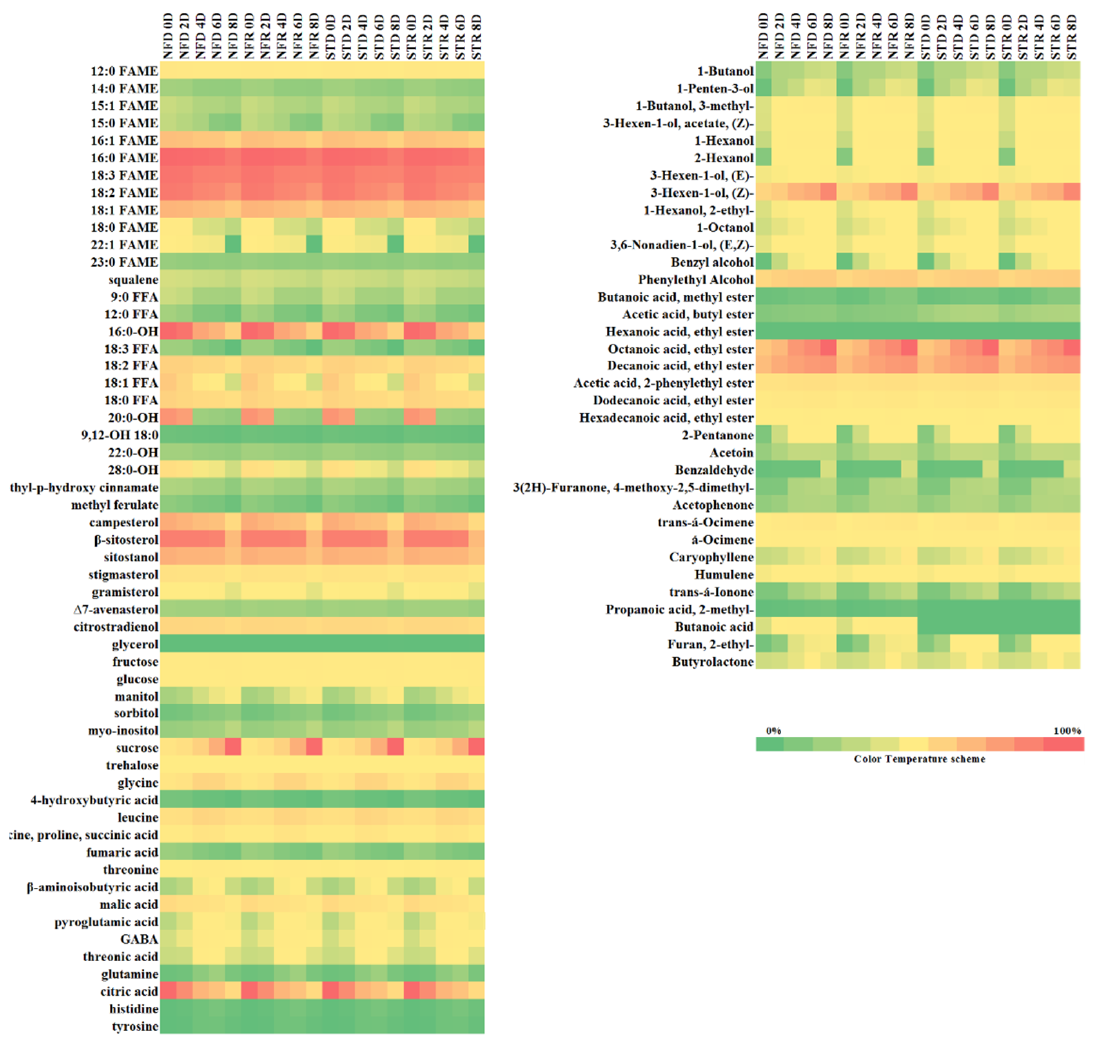
Figure 2. Heat plot of the metabolites and volatile organic compounds detected in dry and rainy season ‘Nam Dok Mai’ mangoes. FAME, fatty acid methyl ester; FFA, free fatty acid; GABA, gamma aminobutyric acid; STD, dry season ‘Nam Dok Mai Si Thong’; STR, rain season ‘Nam Dok Mai Si Thong’; NFD, dry season ‘Nam Dok Mai No. 4’; NFR, rainy season ‘Nam Dok Mai No. 4’. Red, yellow and green colors indicating higher, moderate and lower amounts, respectively.